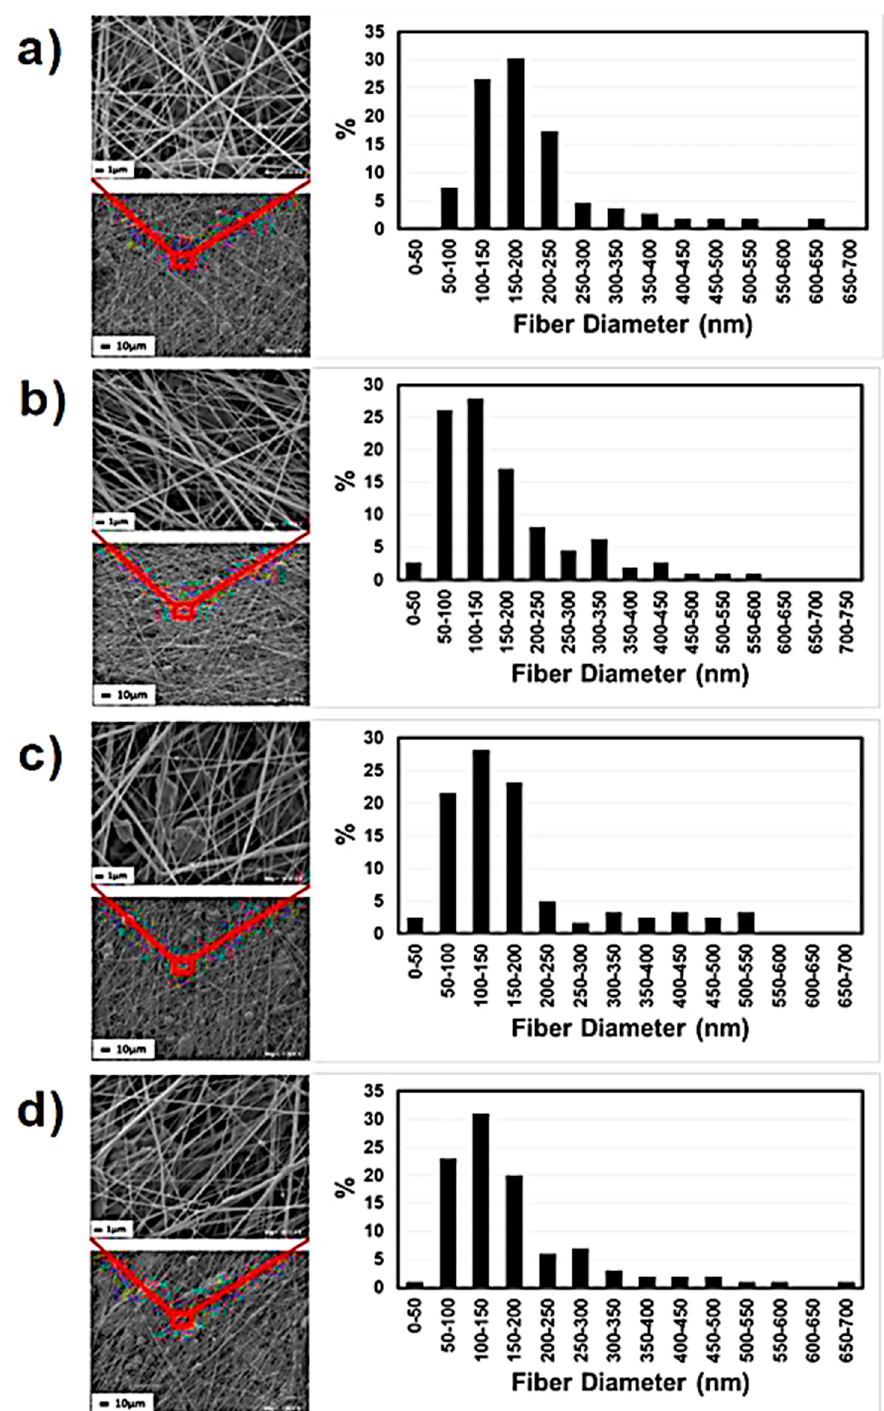
Figure 10. SEM images of solution blown thermoplastic polyurethane fibers with different feed rate values produced: ( a ) 1 mL/h, ( b ) 10 mL/h, ( c ) 25 mL/h, ( d ) 50 mL/h [92].